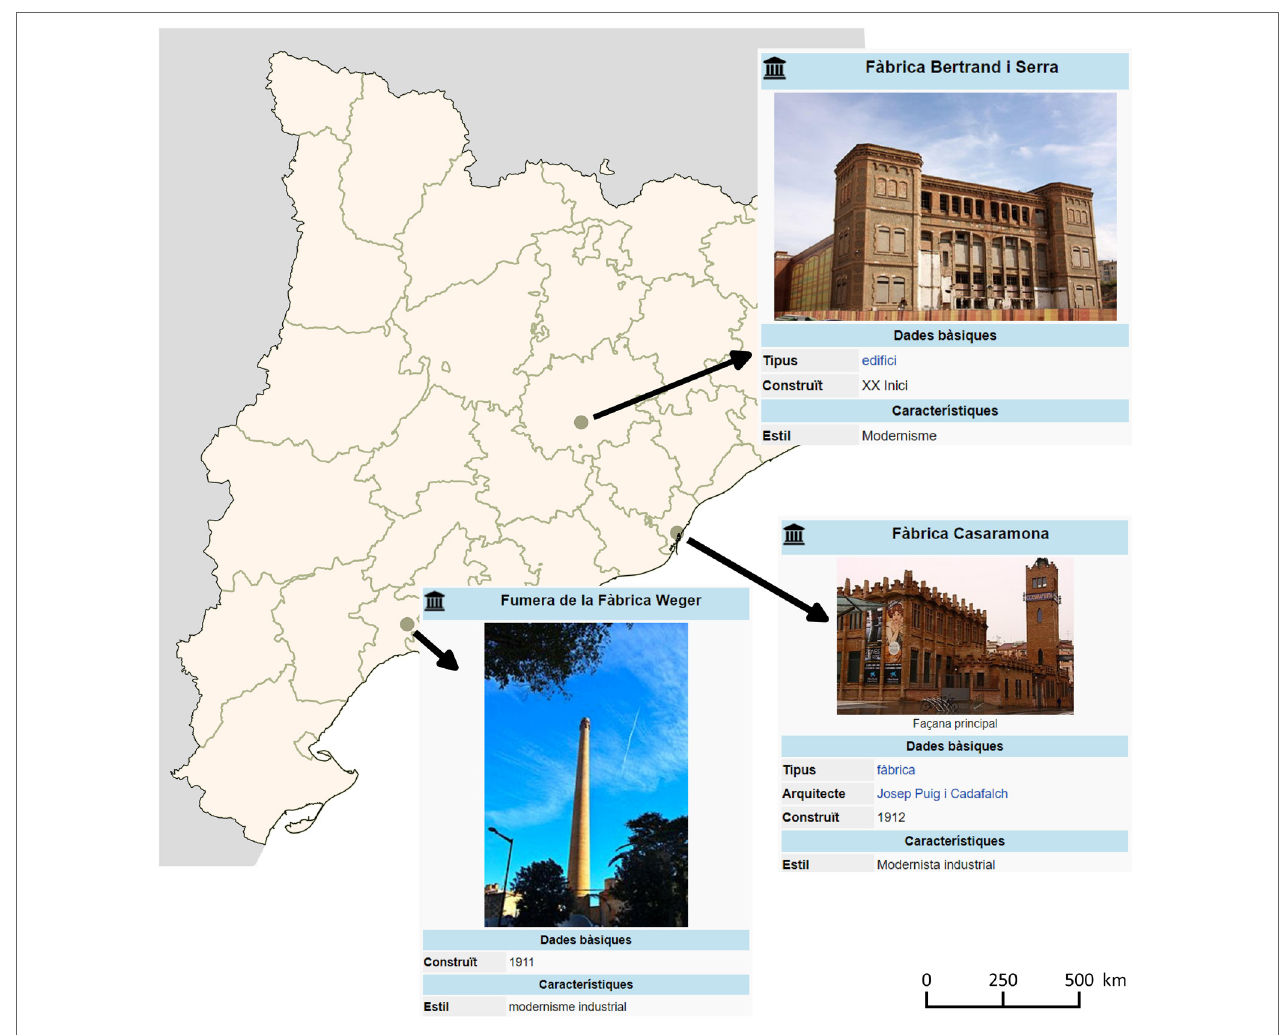
FigUre 11 | Heritage site database, an example. Source: Own